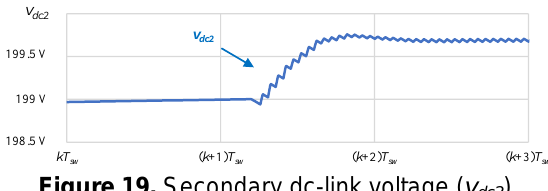
Figure 19. Secondary dc-link voltage ( v dc2 ) regulation considering a TPS